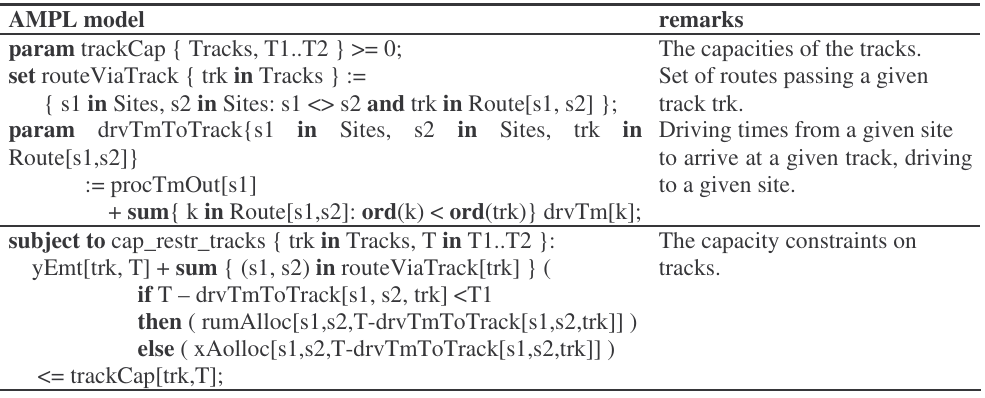
Table 6. Extension of the AMPL model with capacity bound on the roads AMPL